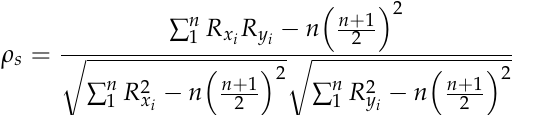
Figure 10. Uncertainty range of hydrogen production in 38 mm LOCA.